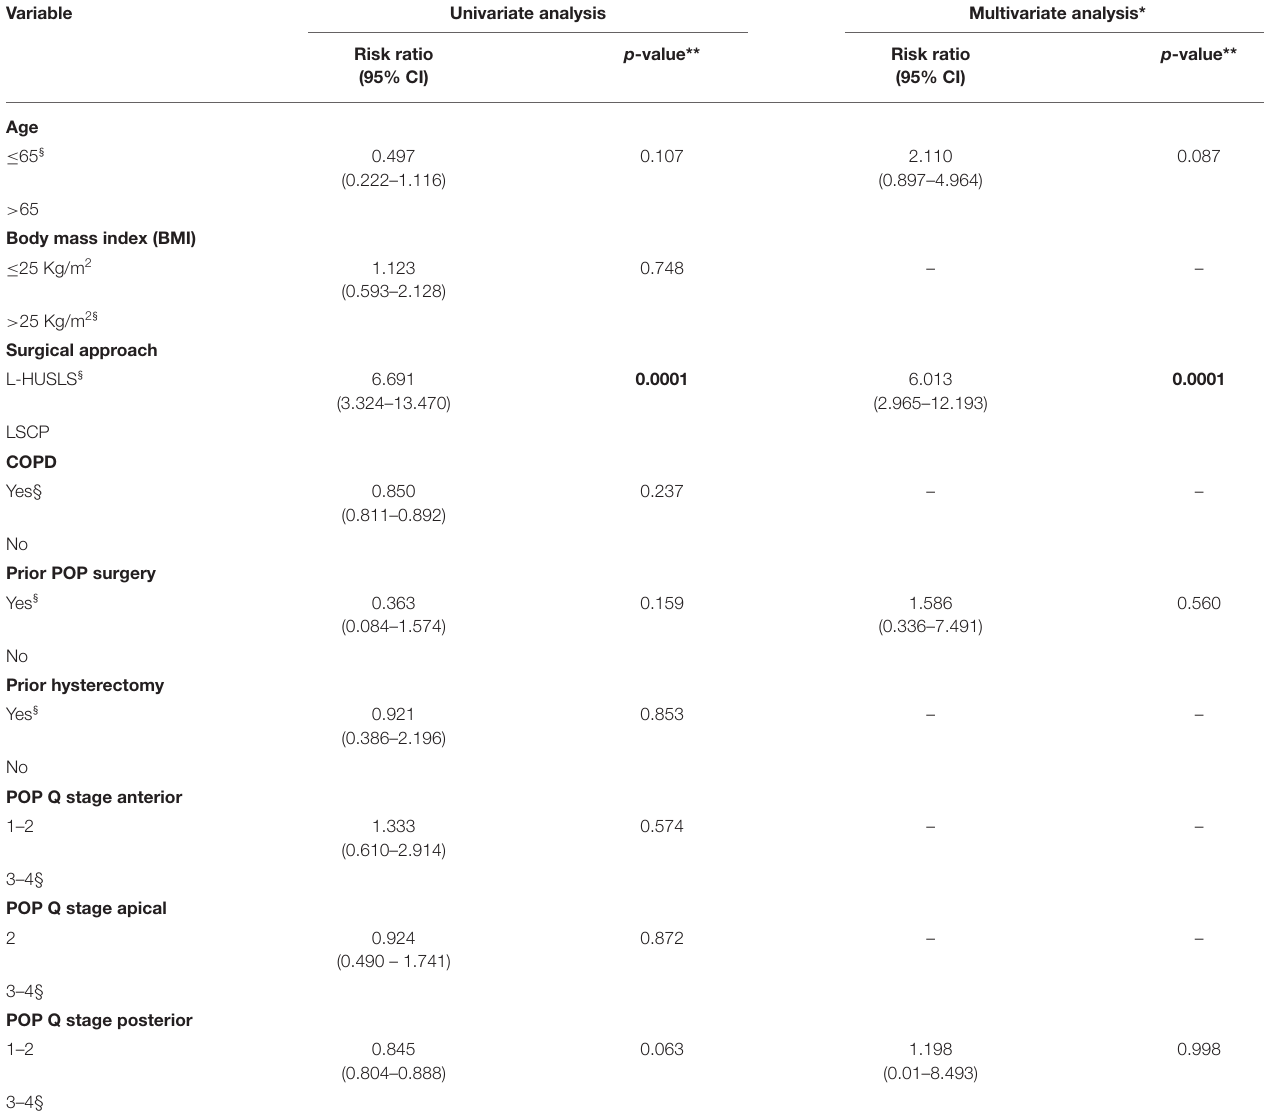
TABLE 4 | Risk factors for prolapse recurrence.